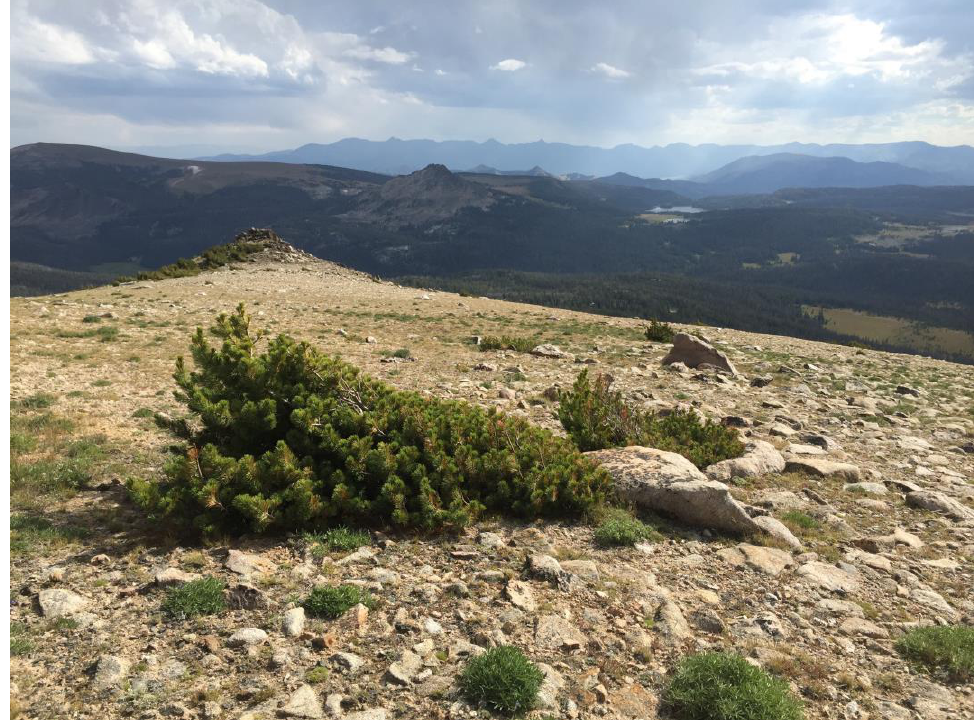
Figure 1. Facilitation at treeline. Whitebark pine ( Pinus albicaulis ) established in the lee of a rock on Tibbs Butte, Shoshone National Forest, Wyoming. Photo credit: Elizabeth R. Pansing.